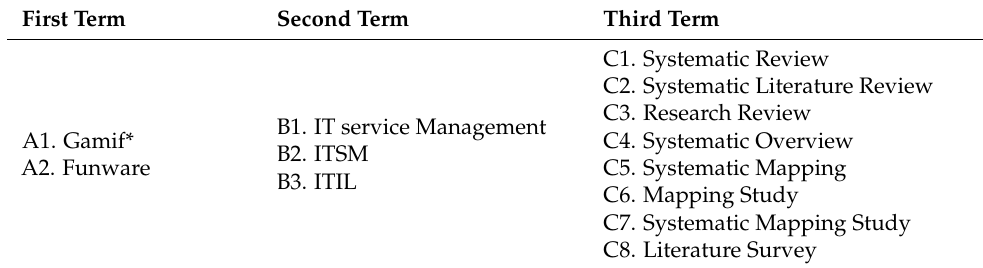
Table 1. Search terms to identify related systematic reviews.